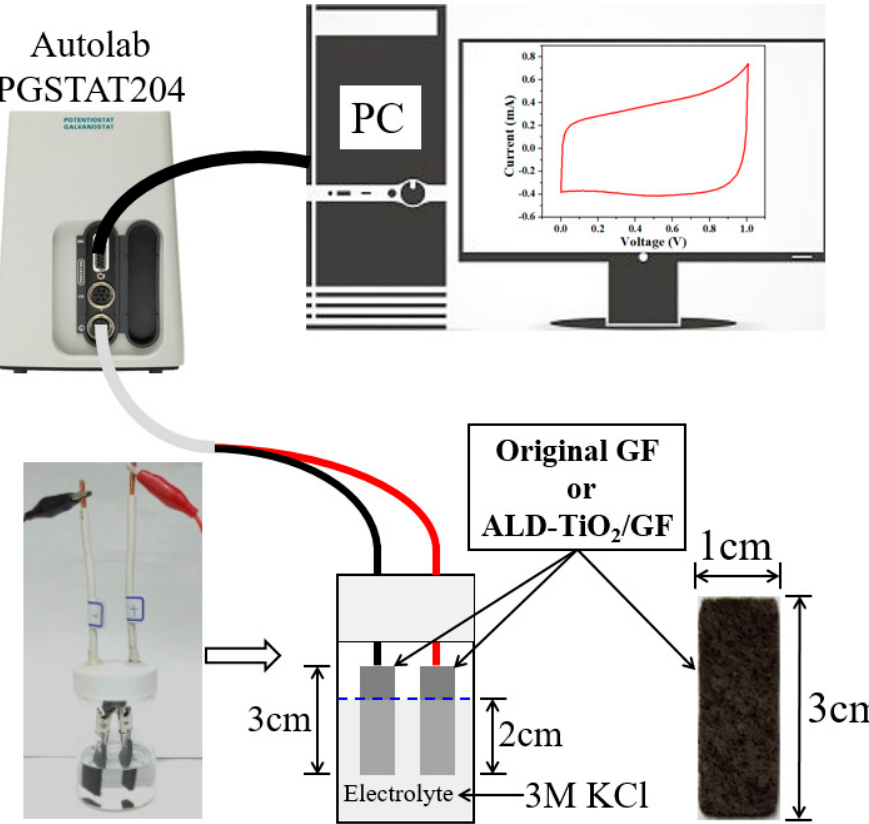
Figure 2. Schematic diagram of the electrochemical measurements.